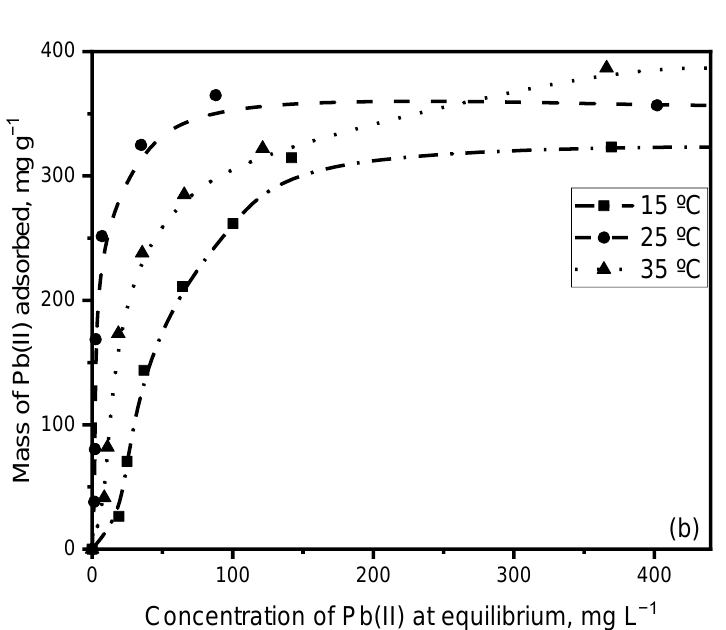
Figure 11. Effect of temperature on the adsorption of Cd(II) ( a ) and Pb(II) ( b ) on Sargassum biomass. Figure 11 shows that a rise in temperature during the sorption process increases the adsorbent capacity throughout the studied range. In the present case, the enthalpy variation is positive, being an endothermic adsorption process. Similar results were obtained by Aksu, 2001 [51], for Cd adsorption on C. vulgaris and by Aravindhan et al., 2009 [54], for dye removal on Caulerpa scalpelliformis